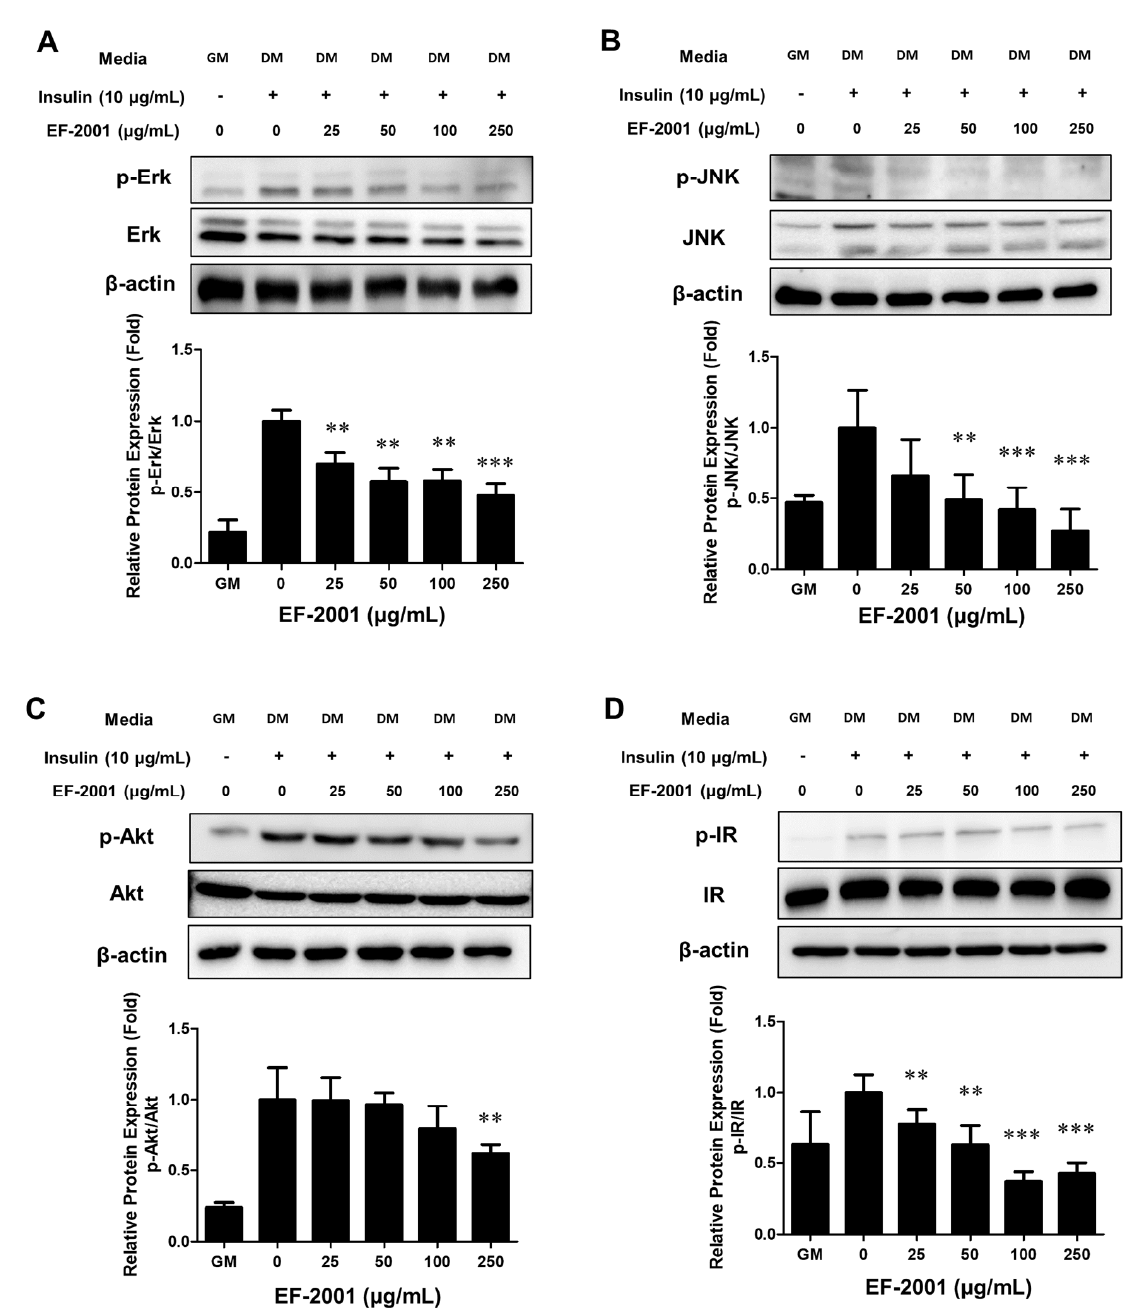
Figure 5. Effects of EF-2001 on insulin receptor pathways in 3T3-L1 adipocytes. 3T3-L1 adipocytes were performed to adipogenesis for 2 days in the absence or presence of various dose of EF-2001. Cells were harvested at the time at which the expression of each insulin signaling protein was induced. Cells were sampled by lysis buffer after insulin treatment for phosphorylated Erk (30 min) ( A ), phosphorylated JNK (45 min) ( B ), phosphorylated Akt (45 min) ( C ), and phosphorylated IR based on phosphorylation detection (15 min) ( D ). Data are represented as mean ± SEM. ( n = 3); ** p < 0.01, and *** p < 0.001 vs. control (without EF-2001 in differentiation